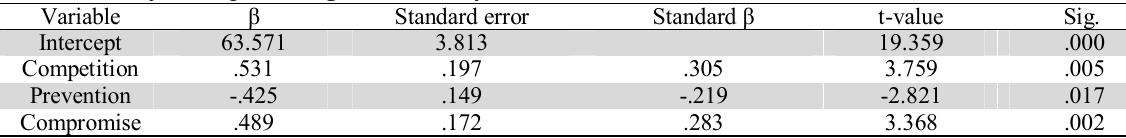
The summary of stepwise regression